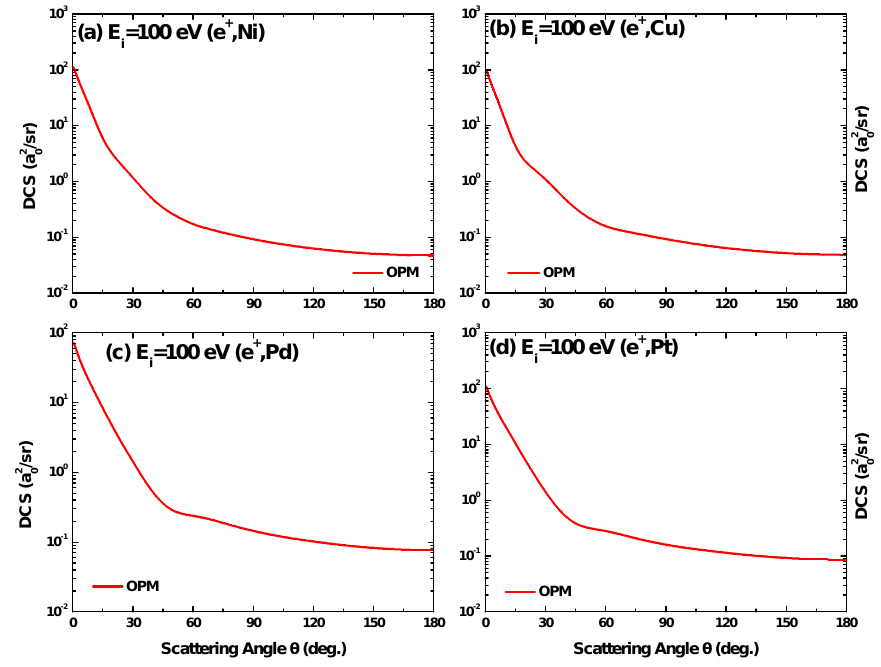
Figure 21. Angular dependence of the differential cross-sections calculated using our OPM approach for 100 eV positron scattering from ( a ) Ni 58 , ( b ) Cu 63 , ( c ) Pd 108 , and ( d ) Pt 196